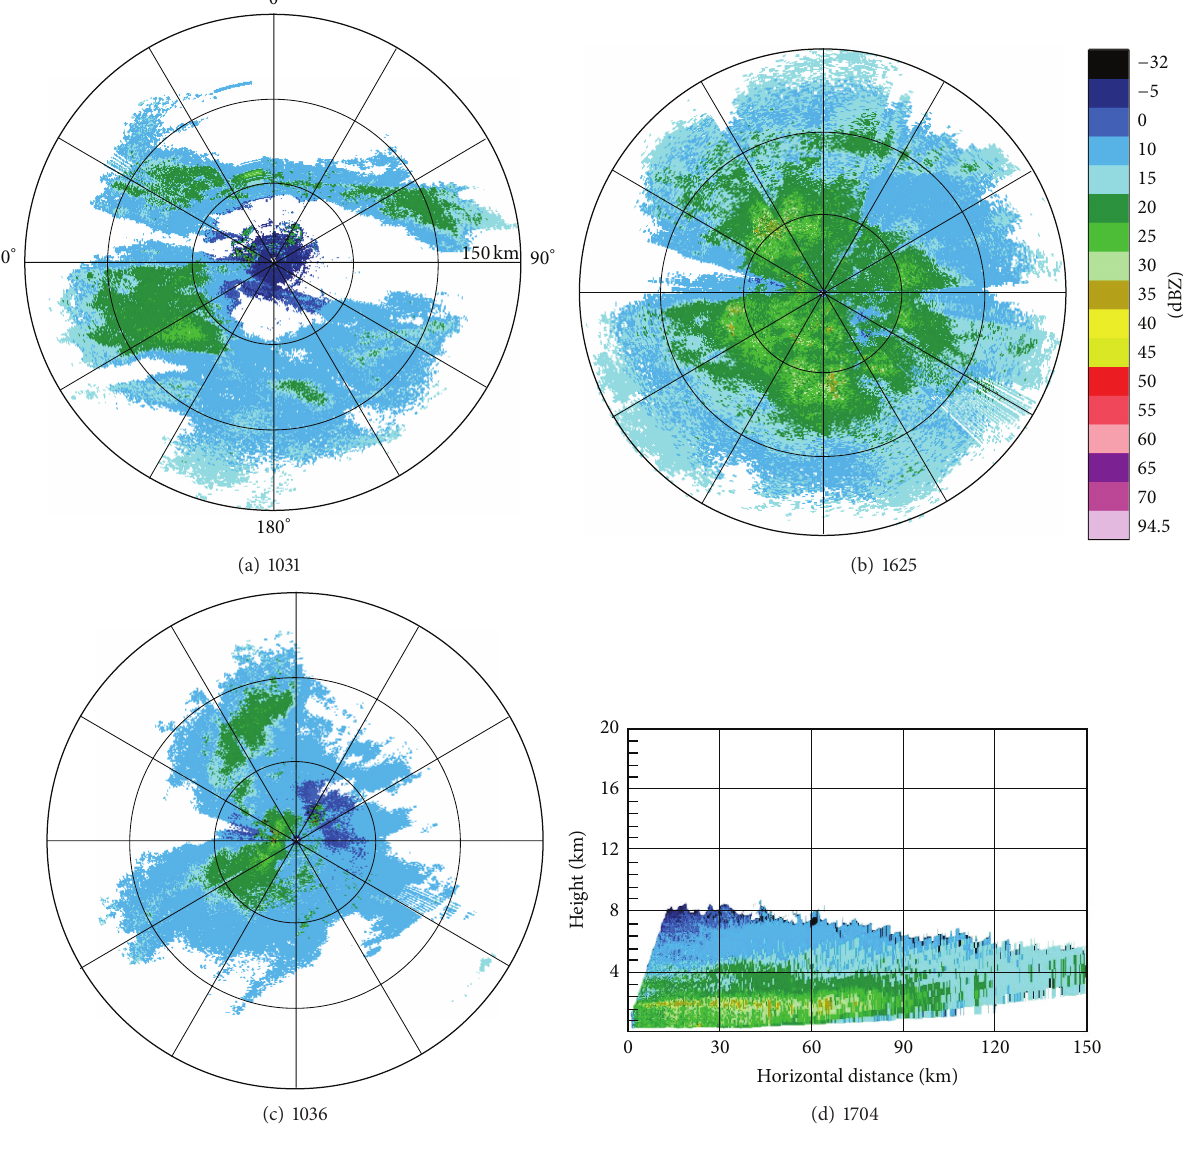
Figure 1: PPI and RHI radar display of the radar reflectivity factor (in dBZ) from the Taiyuan radar at (a) 1031 CST 20 April, (b) 1625 CST 20 April, and (c) 1036 CST 21 April 2010 with an elevation of 1.5 ∘ and at (d) 1704 CST 20 April 2010 with the azimuth of 242 ∘ . The range markers are 50 and 30 km for PPI and RHI images,